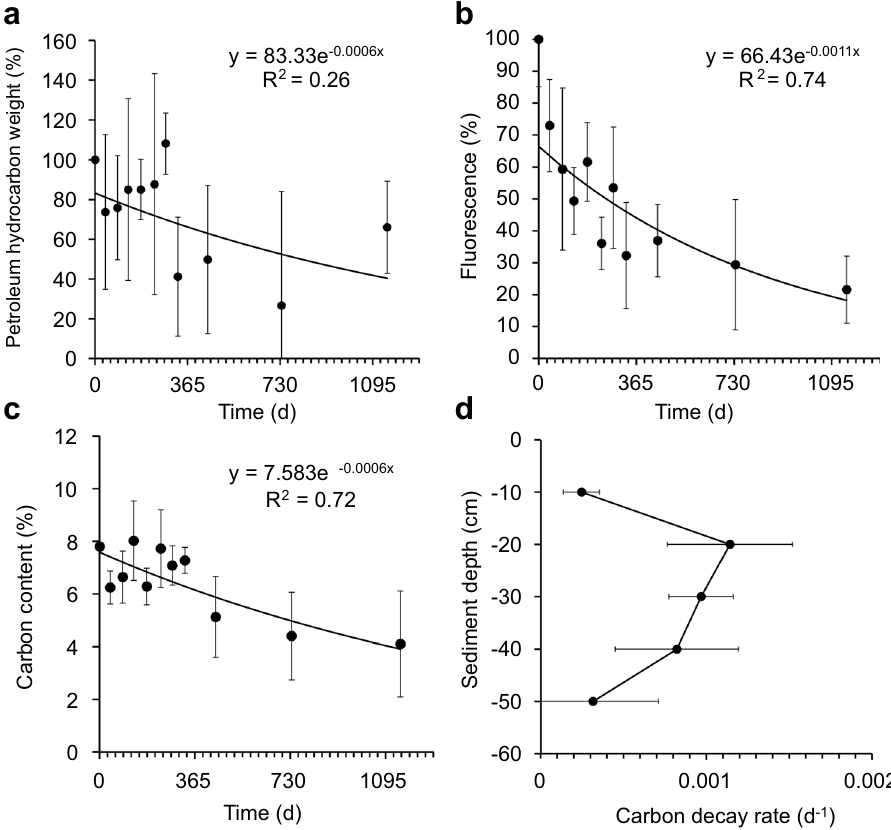
Figure 2. Decreases in sSOA mass, fluorescence and carbon during the in-situ experiment and carbon decay rates ( a ) Decrease of the mass of the hydrocarbons in the sSOAs (starting weight = 100%). The relatively large variability was caused by the sand grains adhering to the sSOAs. ( b ) Decrease of average sSOA fluorescence. ( c ) sSOA carbon loss over time. ( d ) sSOA carbon content decay at different sediment depths. Error bars depict one standard